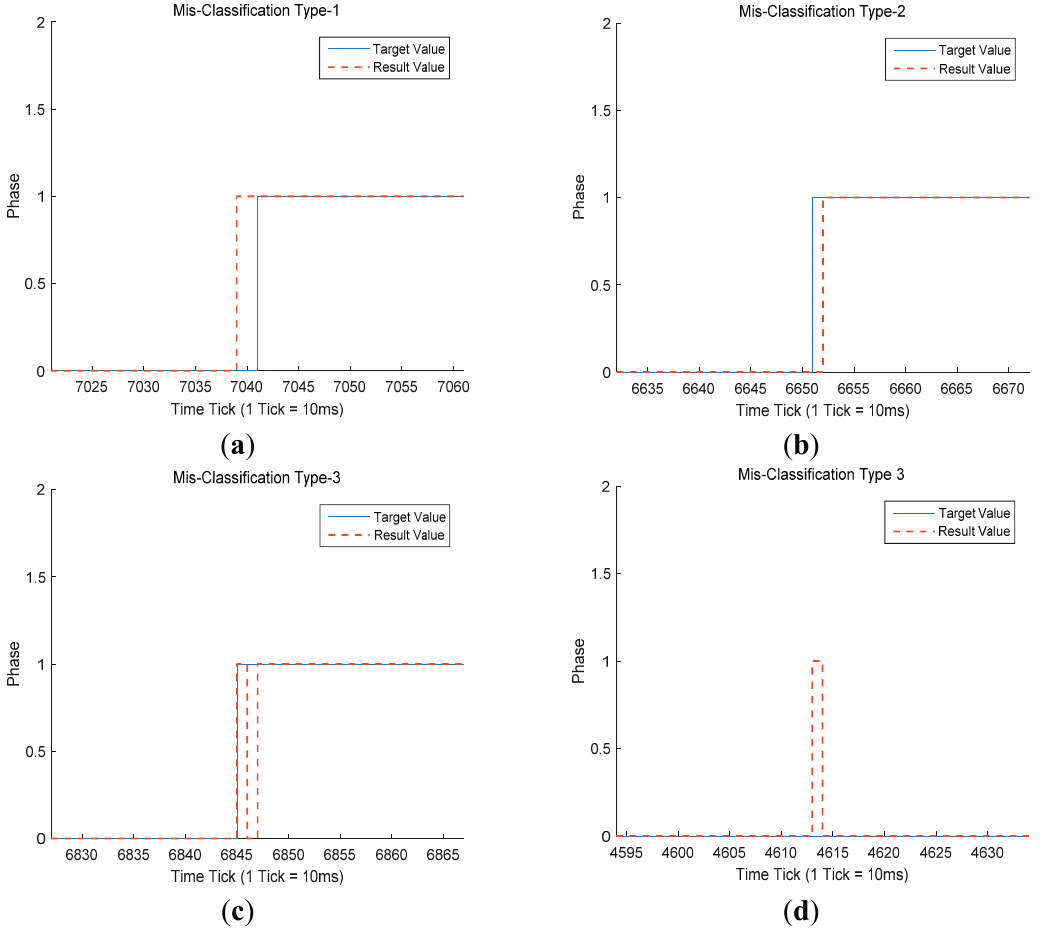
Figure 4. Misclassification types of a gait phase classifier. The blue line denotes target values acquired by the force plate. The orange dotted line denotes the classification